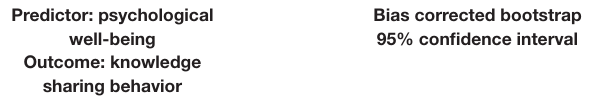
TABLE 6 | Sensitivity analysis of results on the moderating effect of the leader-member exchange. Predictor: psychological well-being Outcome: knowledge sharing